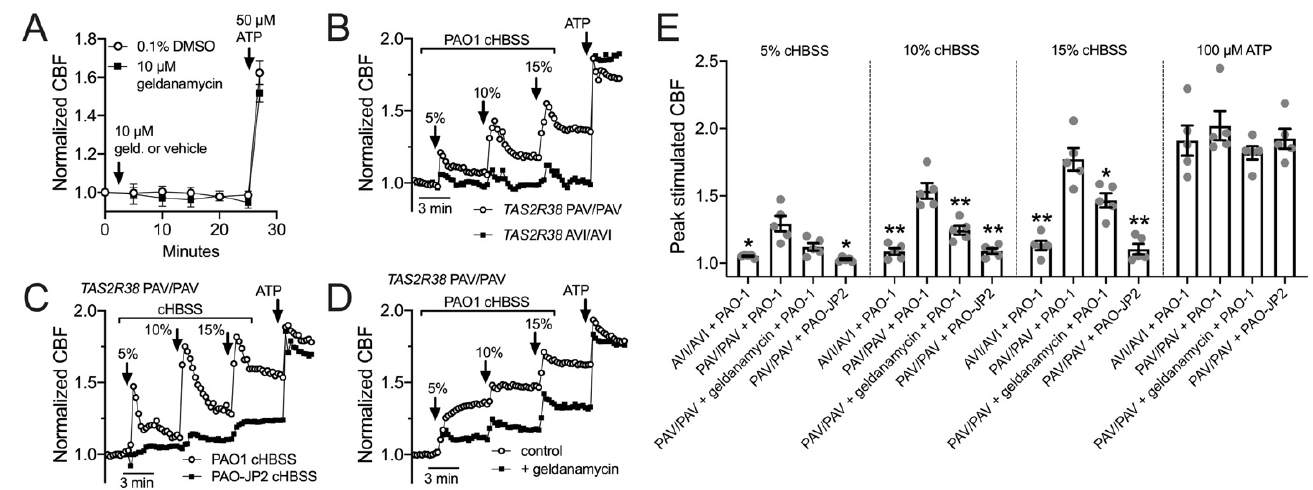
Figure 7. HSP90 inhibition reduces epithelial ciliary response to P. aeruginosa conditioned medium. ( A ): Graph shows real-time measurement of CBF (mean ± SEM of six independent experiments using ALIs from three patients) during prolonged geldanamycin treatment, followed by stimulation with purinergic agonist ATP. ( B ): Primary nasal ALIs genotyped for functional T2R38 (TAS2R38 PAV/PAV) or non-functional T2R38 (TAS2R38 AVI/AVI) were stimulated with diluted HBSS in which P. aeruginosa PAO-1 had been incubated overnight (conditioned HBSS; cHBSS, diluted with unconditioned HBSS). Peak CBF responses to PAO-1 cHBSS were greater in PAV/PAV cells vs. AVI/AVI cells. Representative trace shown from five experiments using cultures from separate individual patients. ( C ): PAV/PAV cells were stimulated with cHBSS from PAO-1 or PAO-JP2, which lacks the ability to produce AHLs. PAO-1 cHBSS stimulated CBF increases that were greater than CBF increases observed with PAO-JP2 cHBSS. Representative trace shown from five experiments using cultures from separate individual patients. ( D ): PAV/PAV cells were stimulated with PAO-1 cHBSS ± geldanamycin pretreatment. Representative trace shown from five experiments using cultures from separate individual patients. ( E ): Bar graph showing peak CBF (mean ± SEM with individual data points showing individual experiments) observed from experiments as in F-H . Asterisks represent significance compared with PAV/PAV + PAO-1 cHBSS at each individual concentration, determined by Sidak’s multiple comparison test; * p < 0.05 and ** p < 0.01.